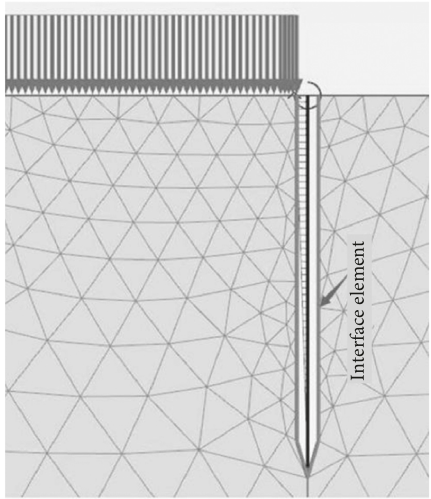
Figure 9: Interface element.